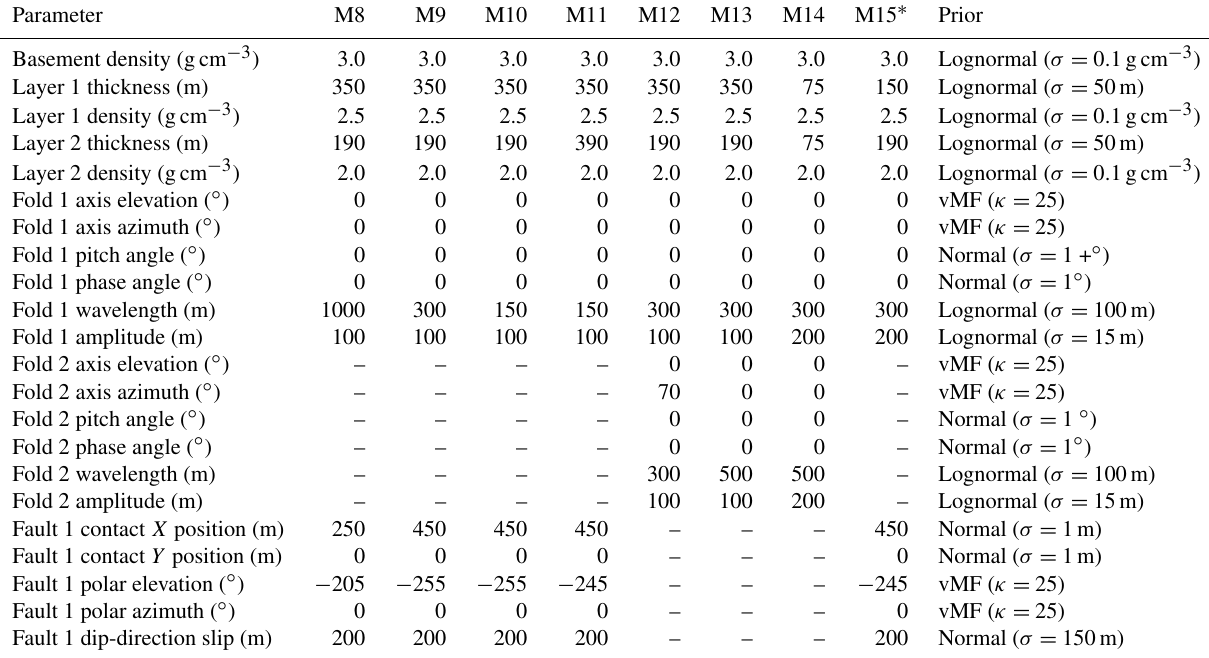
Table 3. Parameter true values and prior distributions for fold-focused kinematic models labeled M8 to M15. ∗ In M15, the stratigraphy is faulted first, then